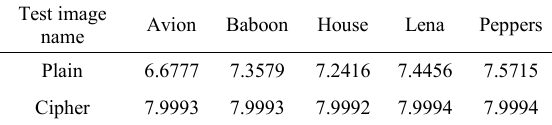
Fig. 3. Histograms of the peppers test image and its output cipher image. (a) the peppers test image; (b) histogram of (a); (c) cipher image corresponding to (a); (d) histogram of (c). Table 3. Results of information entropy